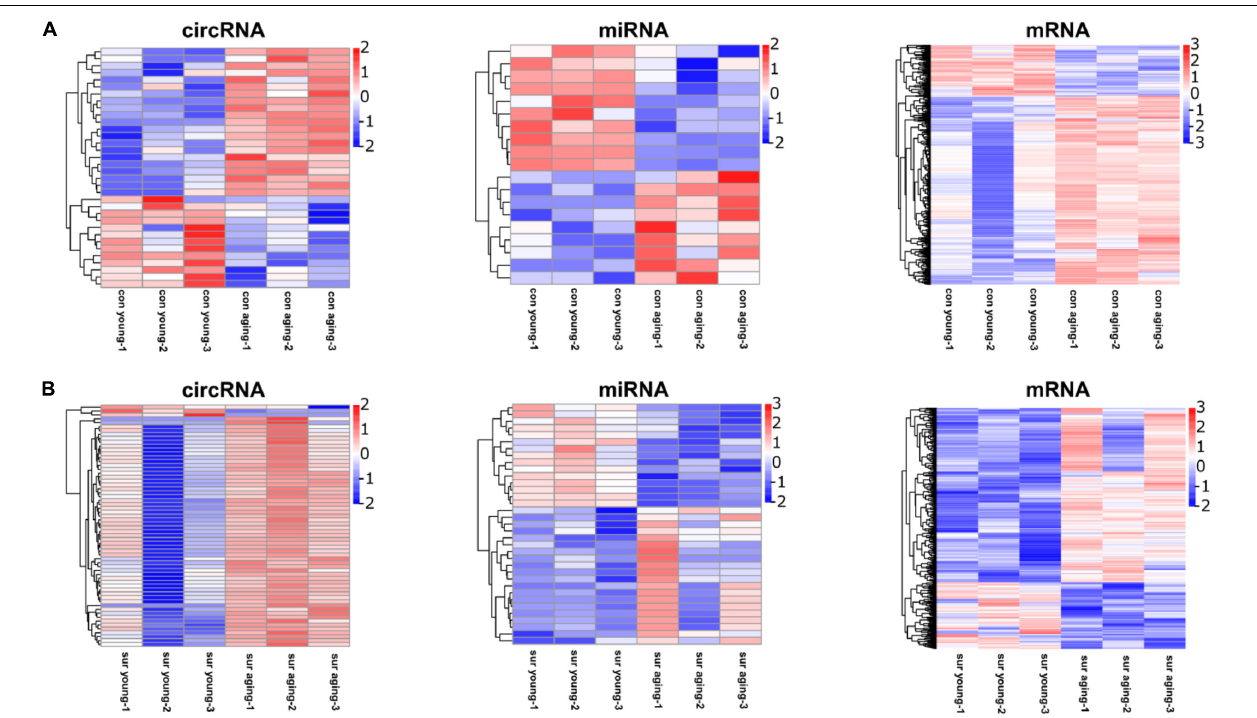
FIGURE 2 | Anesthesia/surgery caused age-dependent changes in the hippocampal transcriptome. (A) Heatmap representing DE circRNAs, miRNAs, mRNAs in hippocampus between young and aging mice under control conditions. (B) Heatmap representing DE circRNAs, miRNAs, mRNAs in hippocampus at 12 h post-anesthesia/surgery between young and aging mice under anesthesia/surgery conditions. DE genes were filtered according to fold change ≥ 2, P ≤ 0.05. n = 3 per group. Pink color represents upregulated expression. Blue color represents downregulated expression.